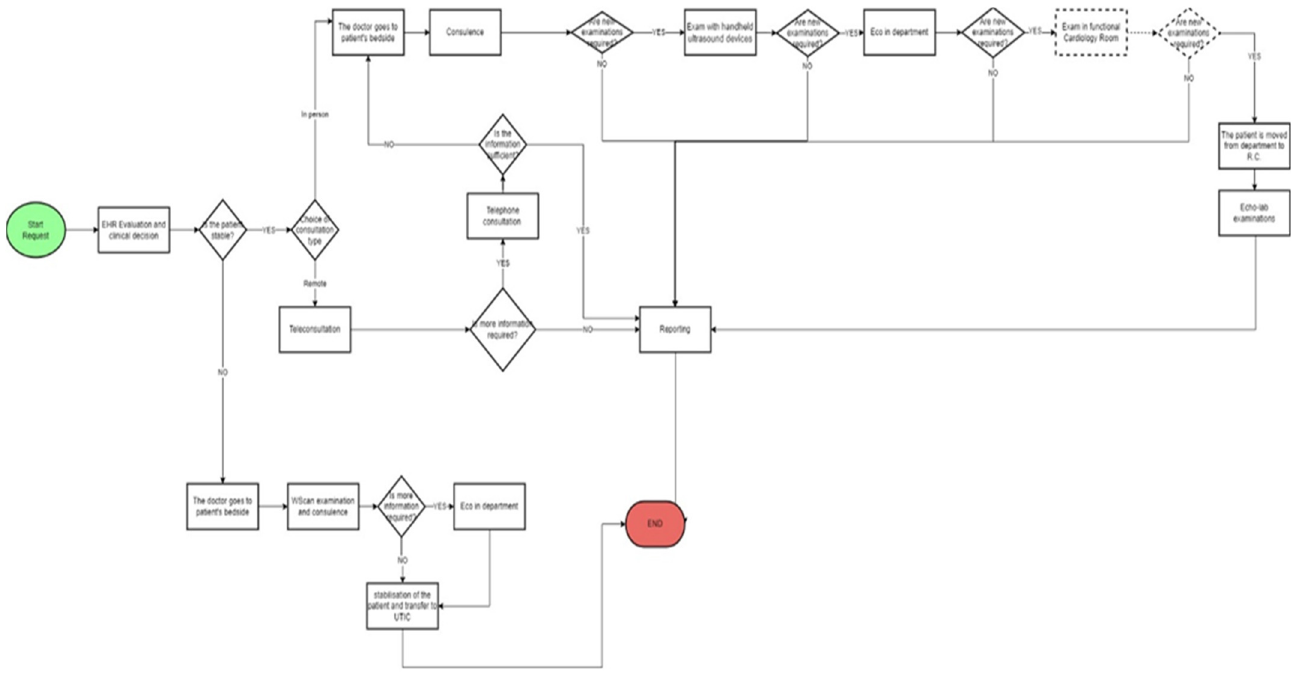
Figure 7. Flow chart of the consultation process after the Lean management intervention with the presence of Functional Cardiology Room.